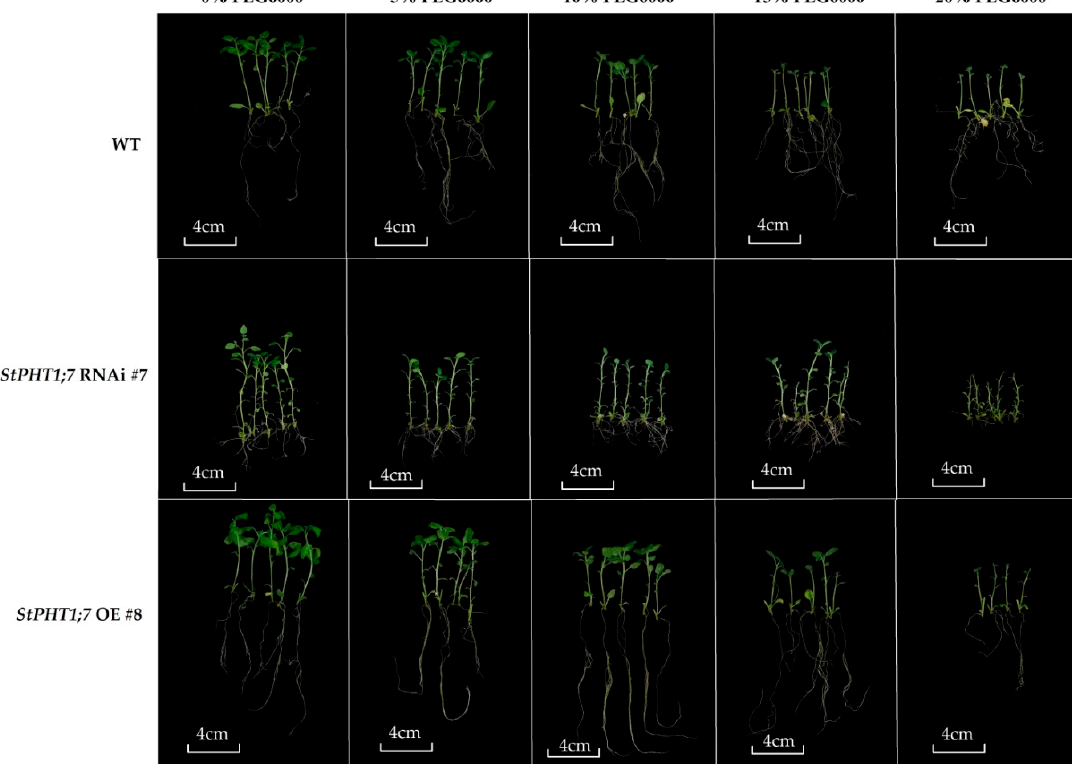
Figure 10. Morphological characteristics of transgenic in vitro potato plantlets under (Polyethylene glycol) PEG treatments. The transgenic in vitro potato plantlets grown for 20 days were transplanted into MS solid medium containing different concentrations of PEG and treated for 25 days.